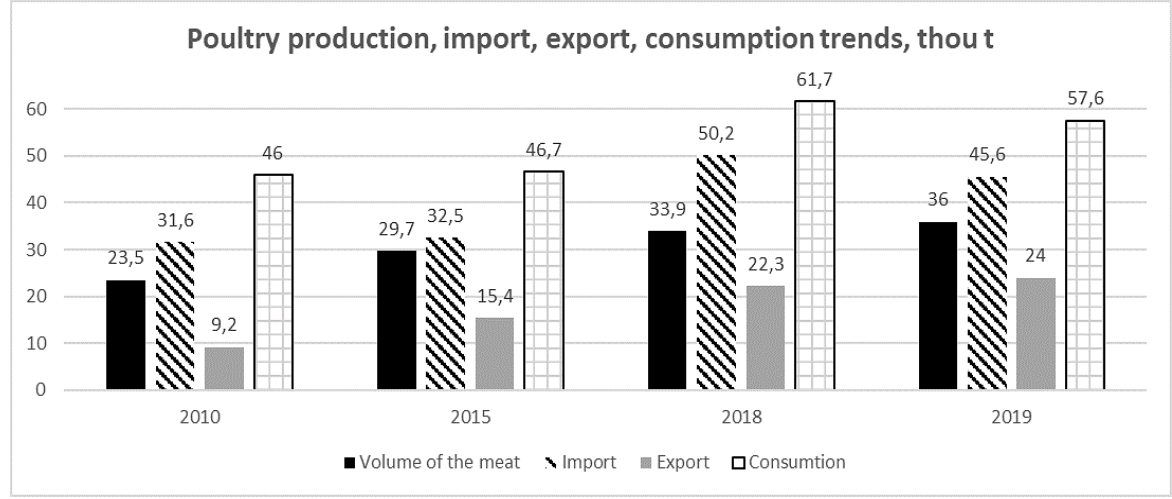
Figure 4. Poultry sector in Latvia, 2010-2019